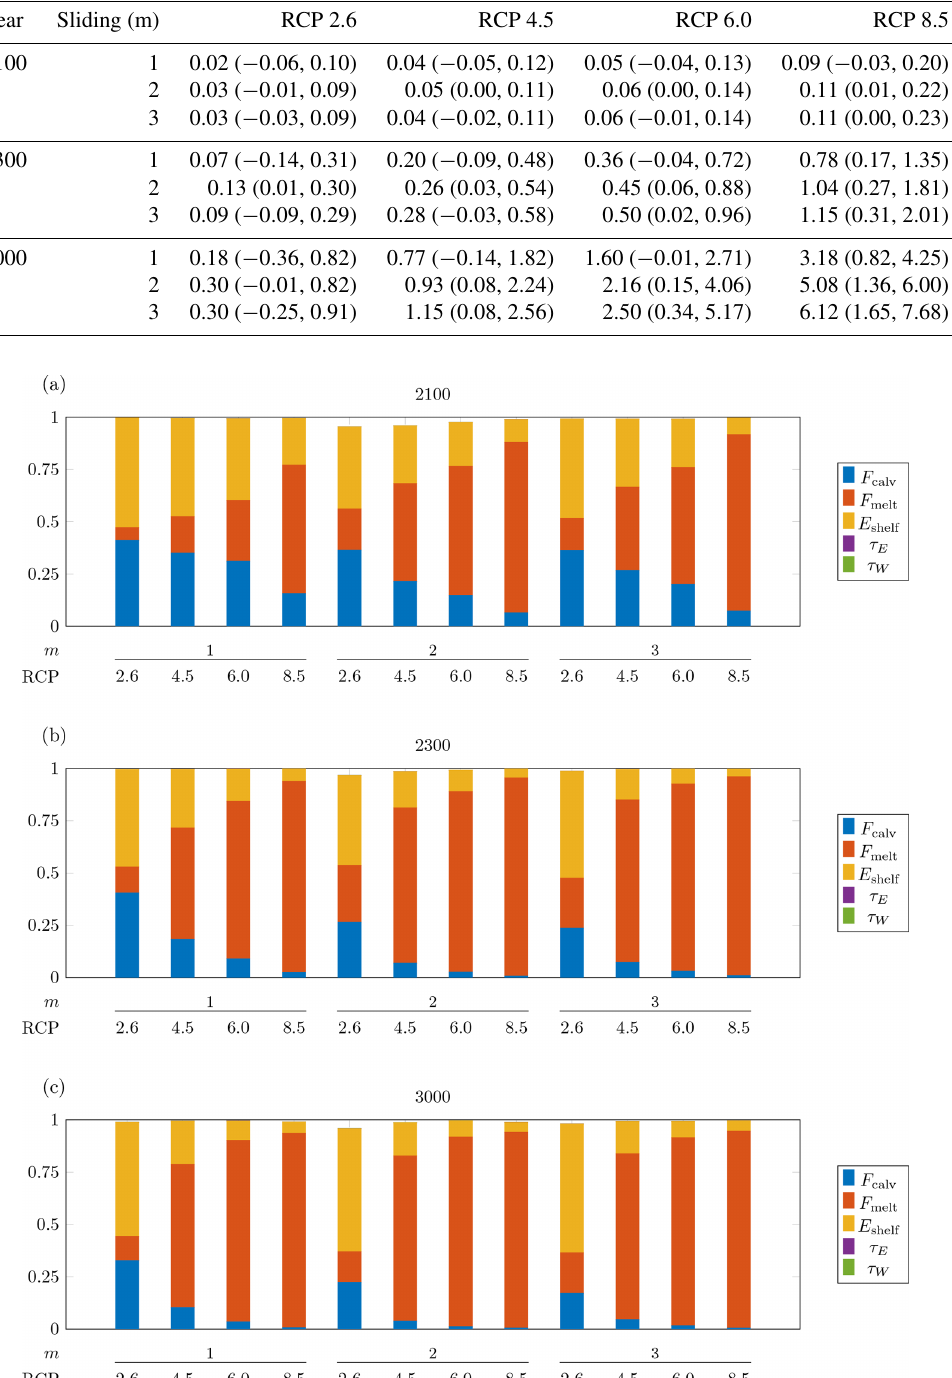
Table 3. Probabilistic projections (in metres) of the AIS contribution to sea level on short-term (2100), medium-term (2300) and long-term (3000) timescales in different RCP scenarios and under different sliding conditions with Schoof’s grounding-line parameterisation. (cid:49) GMSL projections are the median projections with their 5%–95% probability intervals between parentheses.